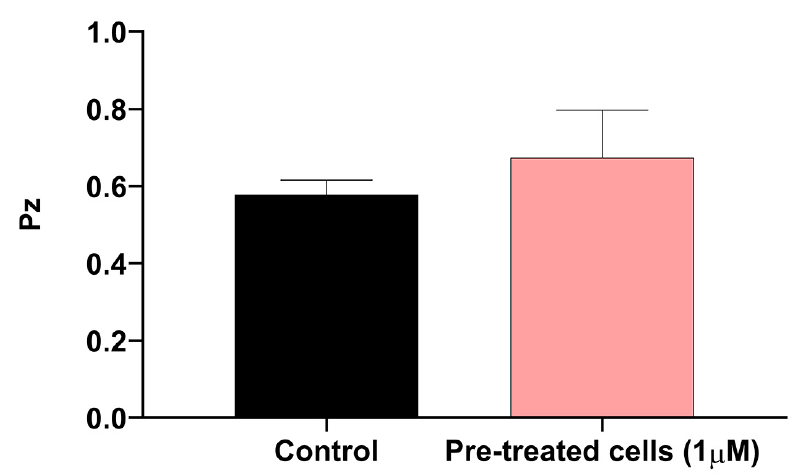
Figure 8. Phospholipase secretion by C. neoformans treated and not treated with 1 µ M of cyclosporine. Statistical significance determined by t test without significant differences.